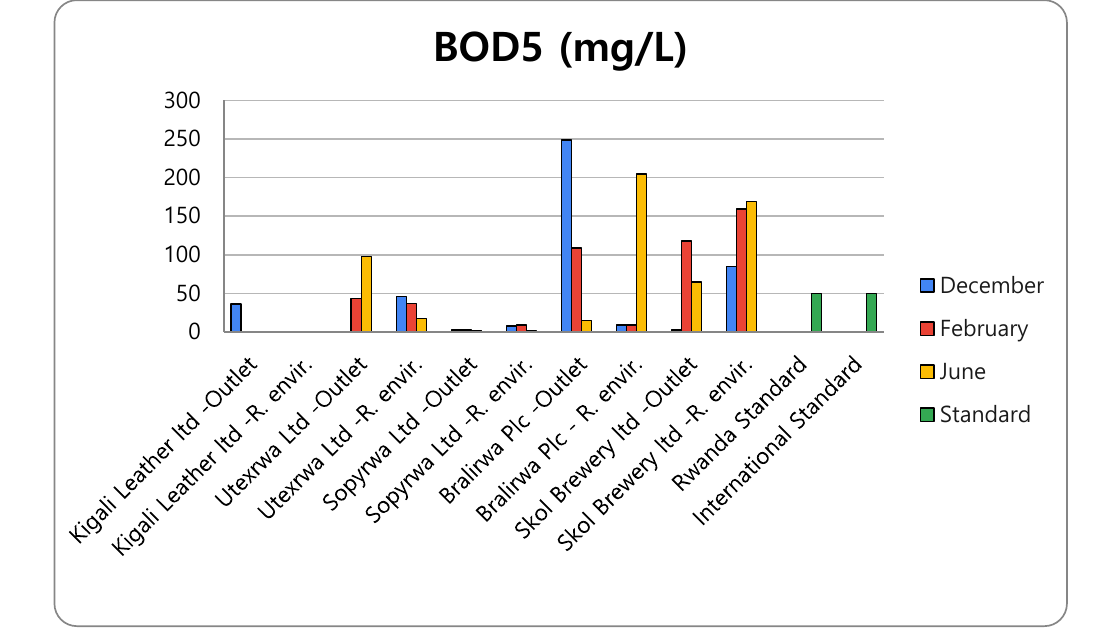
Figure 3. BOD (mg/L) levels per site.